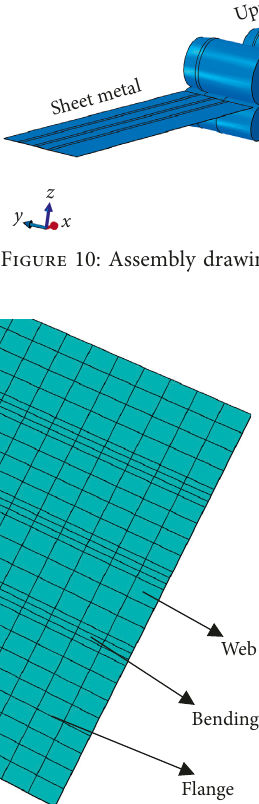
Figure 11: Meshing of b-shaped tube sheet.